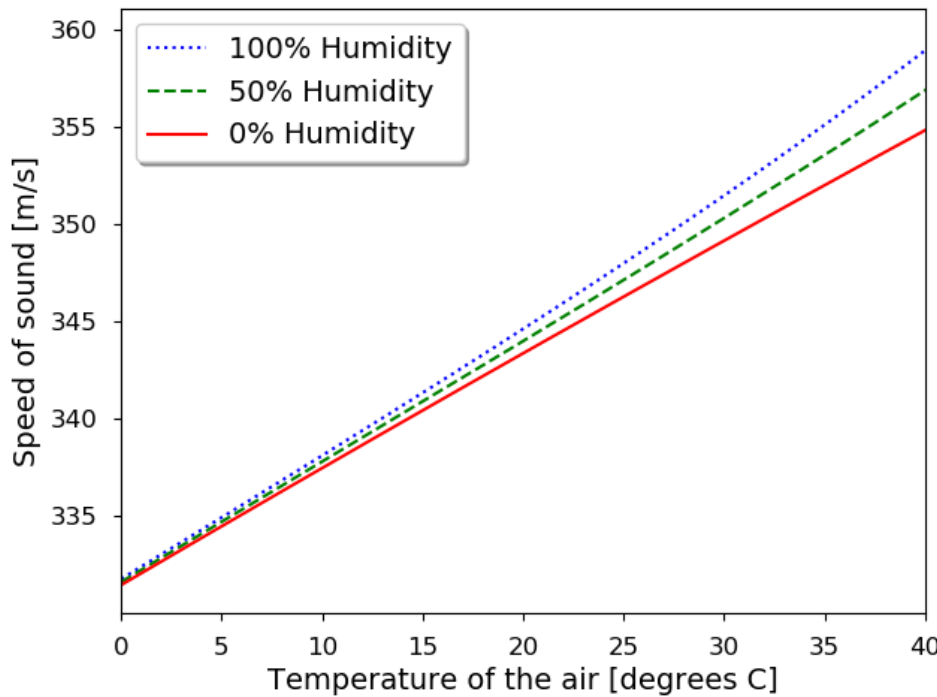
Figure 3. Speed of the sound in the air for different temperatures and three humidity levels. Around room temperature (20 ºC), the variation with air temperature is almost linear, and the influence of the humidity is quite contained. In the case that this speed is used to measure a distance, placing an obstacle at one meter can give different results. A variation of 10 ºC gives a 3.5 cm error. To compare, for humidity, the difference between 0% and 100% is 0.7 cm. Thus, assuming room temperature and 0% humidity can give an error of